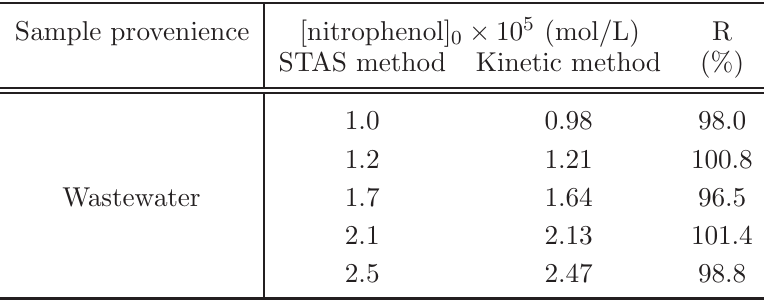
Table 4 Recovery of nitrophenol concentration determined in